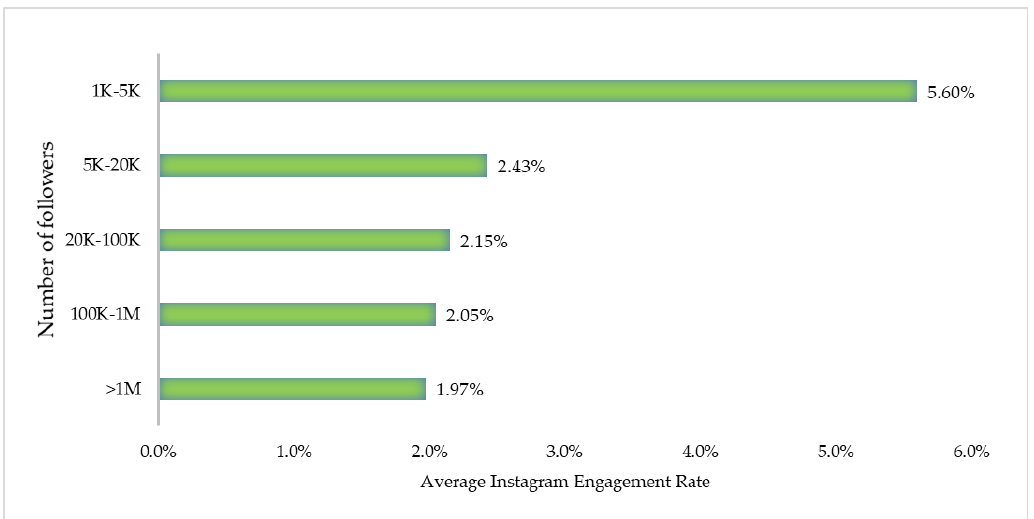
Table 1. The comment evaluation form used during the study with examples. NWKM